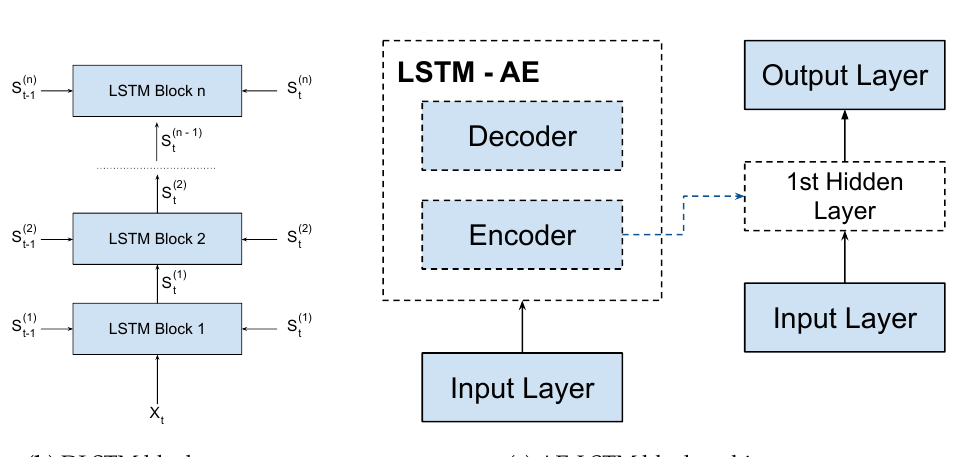
Figure 1. LSTM, DLSTM, and LSTM-SAE